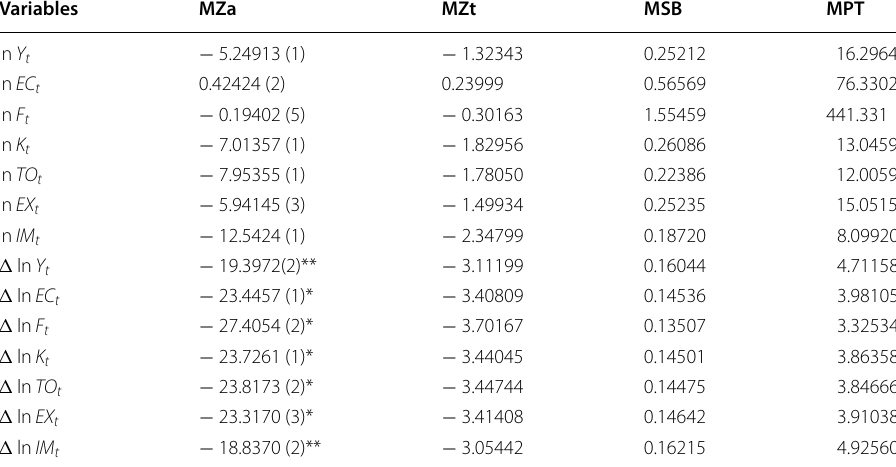
Table 1 Unit root tests results